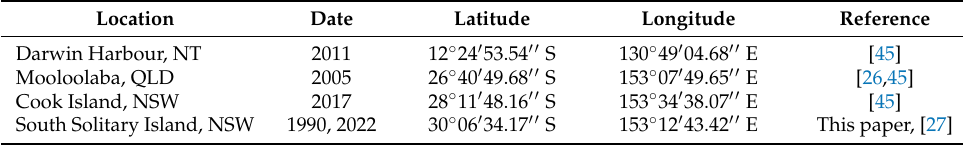
Table 4. Australian distribution records of Hypselodoris sagamiensis .